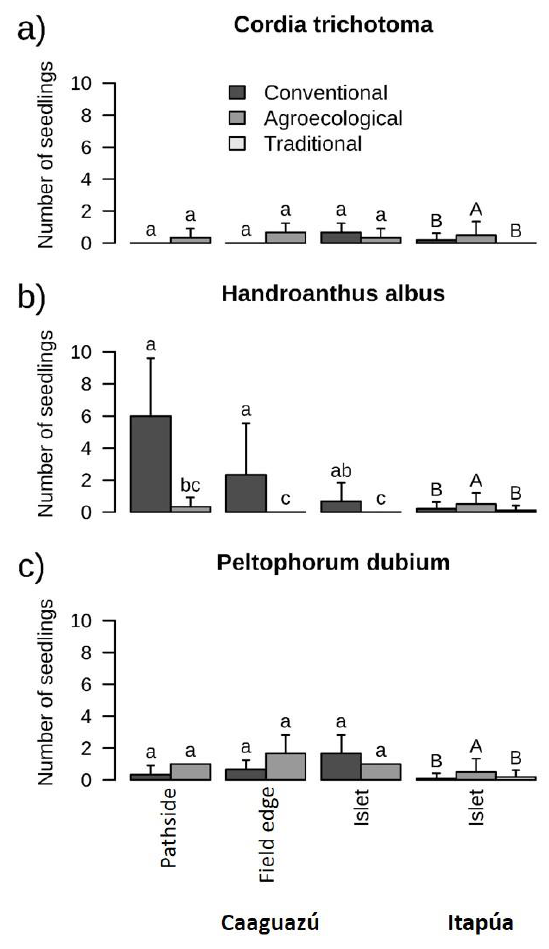
Figure 4. Number of naturally regenerated individuals of ( a ) Cordia trichotoma , ( b ) Handroanthus albus , and ( c ) Peltophorum dubium in Caaguazú and Itapúa. The letters "a", "b", "c", "ab", "bc", "A" and "B", are statistical differences and similarities between types of plantations.